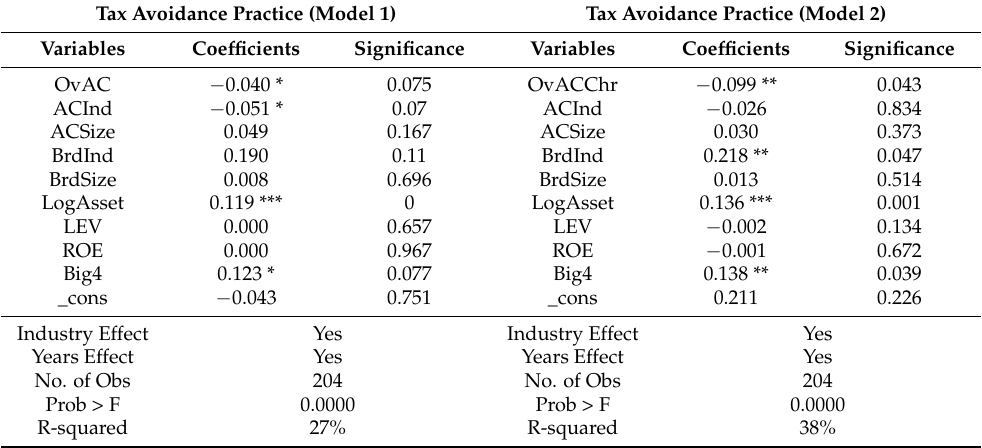
Table 5. Regression